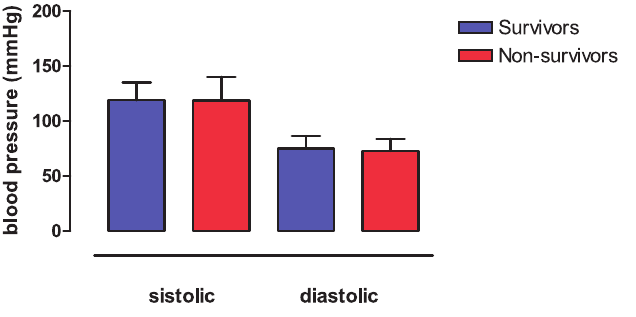
FIGURE 1 - Systolic and diastolic arterial pressure levels in patients of the survivors and non-survivors groups.